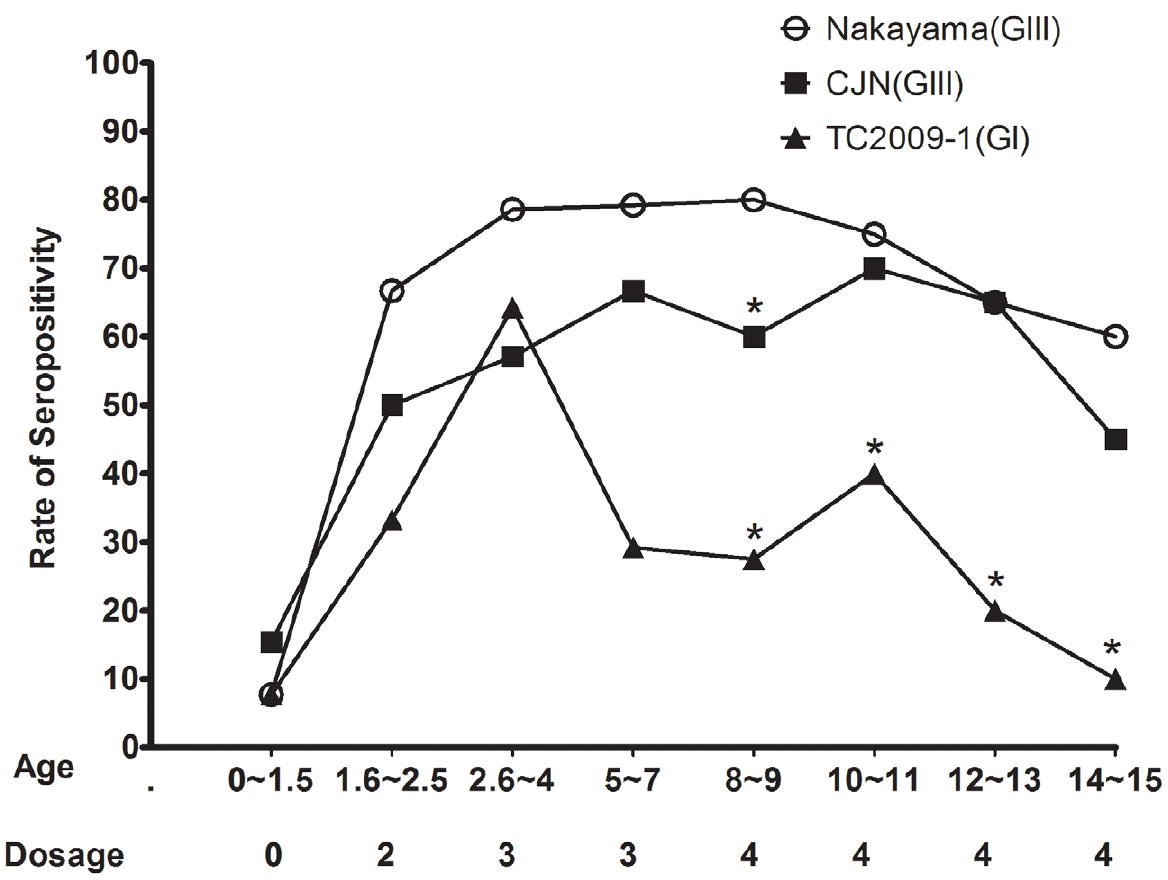
Figure 2. The seropositivity rate of children immunized with inactivated Nakayama JEV vaccine against JEVs. Seropositivity is defined by a reciprocal titer of $ 10 in a 50% plaque-reduction neutralization test using BHK-21 cells. Significantly different (P , .05) seropositivity rates against CJN or TC2009-1 as compared to that for Nakayama virus are indicated by asterisks.